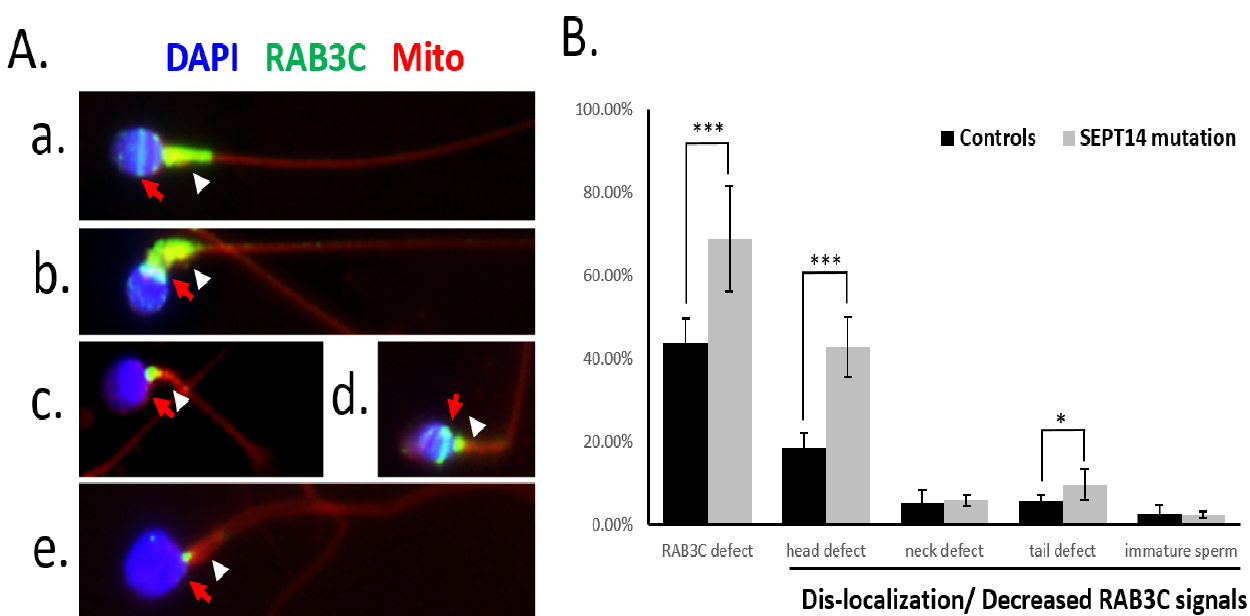
Figure 2. Delocalization/decreased RAB3C in the mutated SEPT14 -harboring human sperm. ( A ) RAB3C protein signals are shown over the postacrosomal region (red arrow) and midpiece (white arrowhead) in normal human sperm ( a ) Spermatozoa from SEPT14 -mutated sperm with neck ( b , c ), and tail defects ( d ) and head ( e ). DAPI, RAB3C, and mitochondria are labeled in blue, green, and red, respectively. ( B ) High percentages of delocalized/decreased RAB3C in the SEPT14 -mutated sperm, compared with the healthy controls. The Y -axis indicates the frequency of delocalized or decreased RAB3C signals in spermatozoa (defined as the number of spermatozoa with delocalized or absent RAB3C signals/total number of spermatozoa). Black bars: controls (normozoospermic sperm); gray bars: SEPT14-mutated sperm. The abnormal spermatozoa morphologies were divided into four subgroups according to the following morphological criteria: head defects, neck and tail defects, and immaturity. (*** p < 0.001, * p < 0.05, ns = non-significant; unpaired t -test. Error bars indicate ± SD).